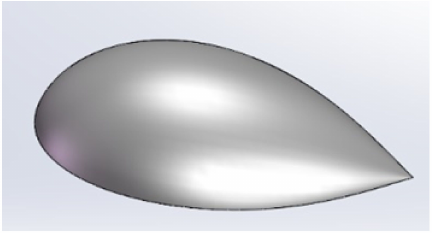
Figure 2. Structure diagram of bionic convex hull.